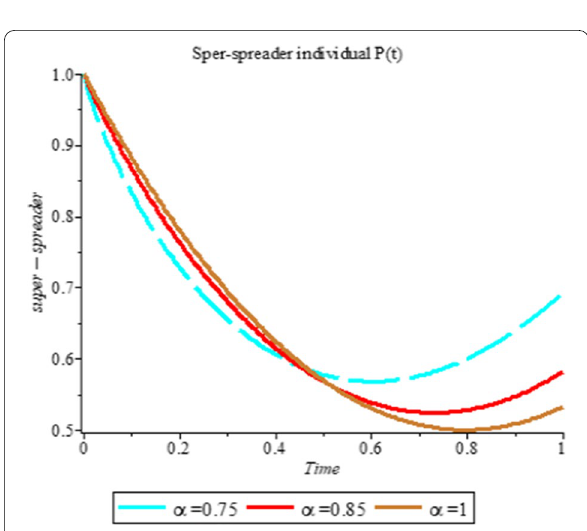
Fig. 7 Plot shows the behavior of H ( t ) at different values of fractional order